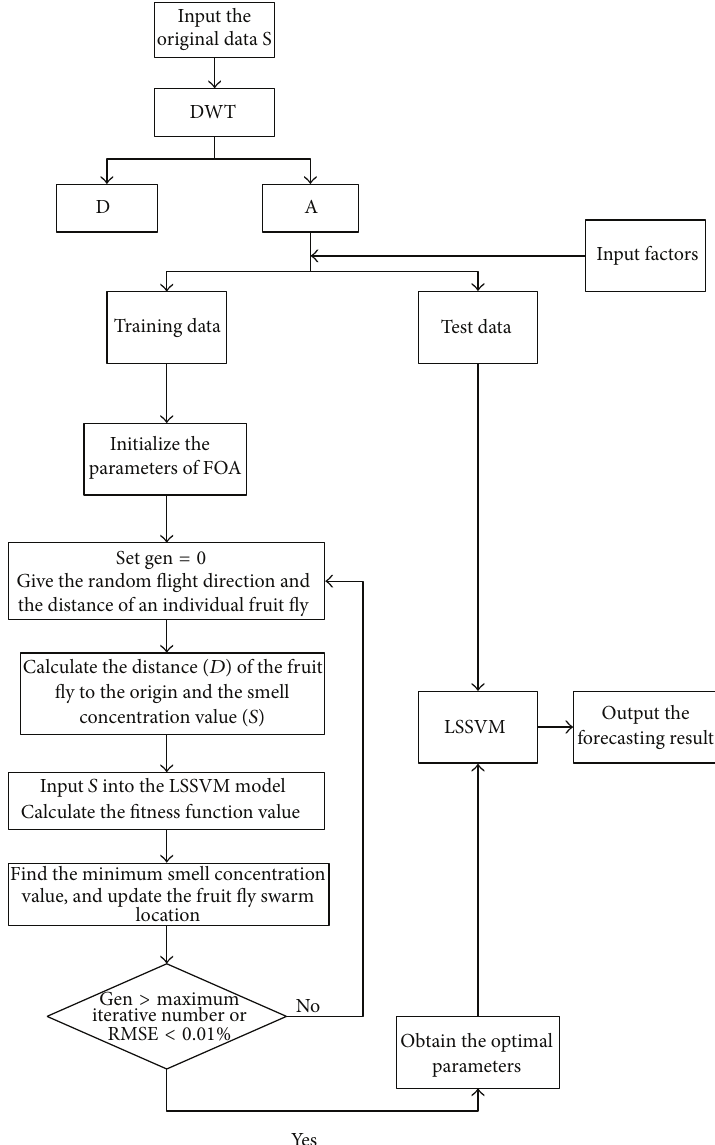
Figure 3: Flowchart of the WT-FOA-LSSVM modeling.